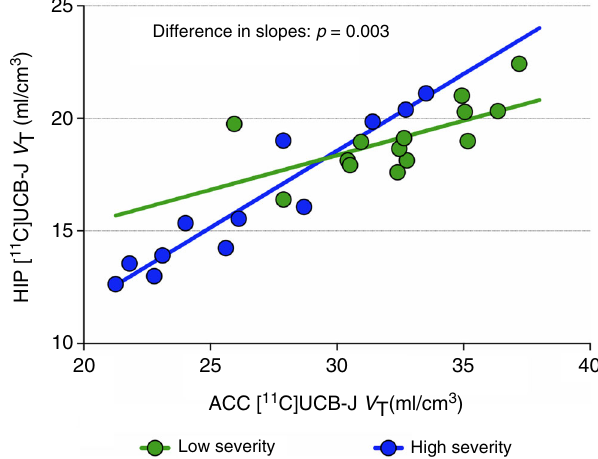
Fig. 4 Stronger ACC-hippocampus correlation in SV2A density in high severity vs. low severity clinical groups. Differences in correlations between ROIs were assessed using Fisher ’ s r to z transformation. ACC: